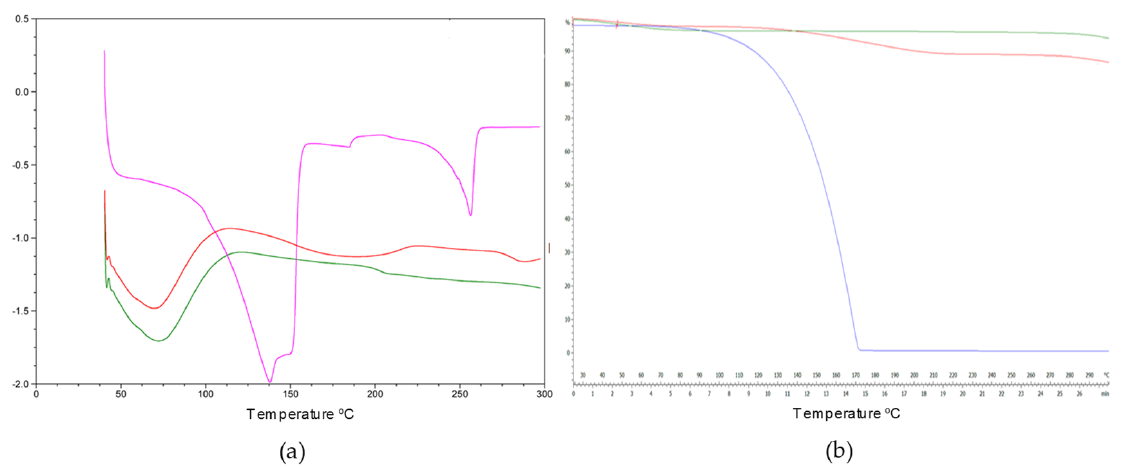
Figure 9. ( a ). Curves of the DSC carvacrol (pink line), MWI carvacrol-HP- β -CDs (red line), and HP- β -CDs (green line). ( b ). The TG curves of HP- β -CD (green line), MWI HP- β -CD/carvacrol (red line), and carvacrol (blue line).